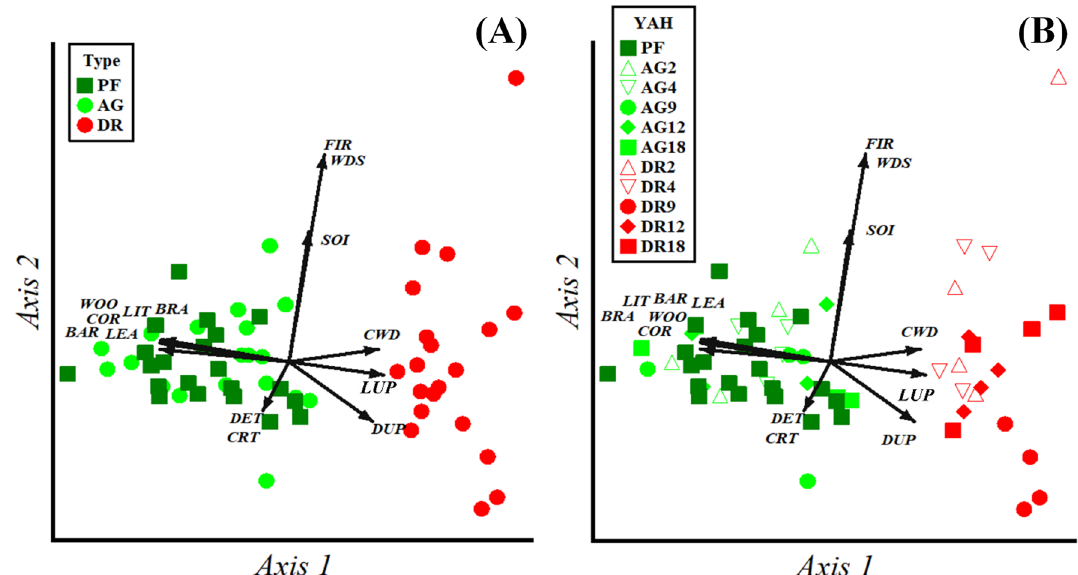
Fig. 4 Principal component analyses (PCA) for carbon content (t C ha − 1 ) considering different forest treatments: A primary forest (PF) and retention types (AG: aggregated retention, DR: dispersed retention), and B PF and retention types at different years‑after‑harvesting (2 to 18). Acronyms are shown in Table 1. Importance of each PCA component (Axis 1 and Axis 2) is detailed in Additional file 1: Appendix